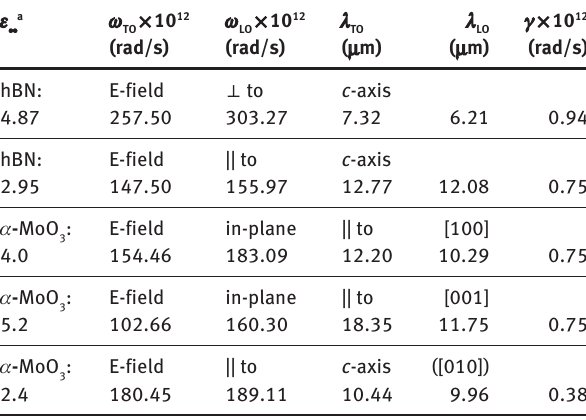
) [out-of-plane ( A )] phonon modes for hBN. 1 u 2 u Table 5: Anisotropic PhP responses of vdW crystals: hBN and α -MoO 3